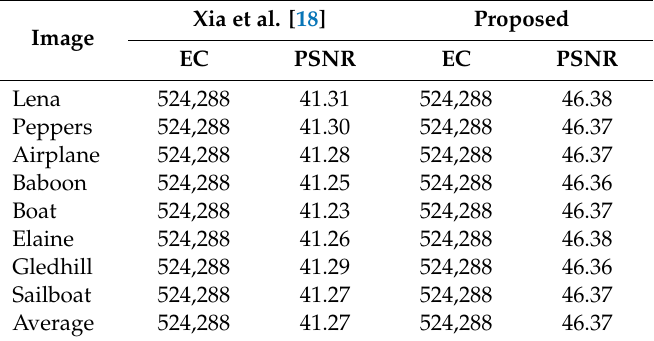
Table 5. Comparison with the 3D SuDoKu matrix-based